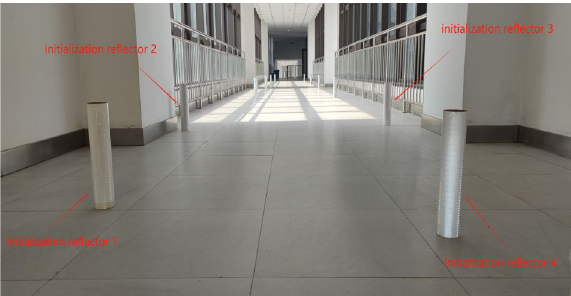
Figure 9. The actual layout environment of reflectors.